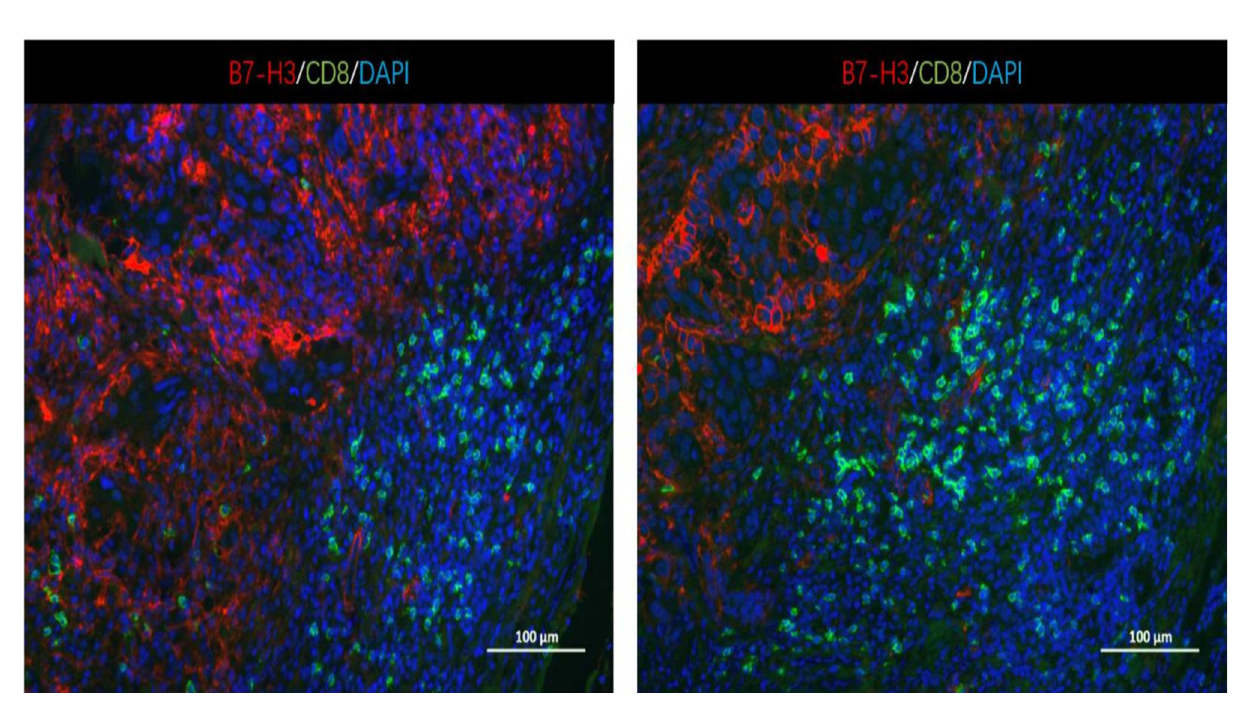
FIGURE 7 | Representative immuno fl uorescence images of B7-H3 and tumor-in fi ltrating CD8 + T cells in LSCC tissues. Original magni fi cation ×100; scale bar, 100 m m. No apparent colocalization of the B7-H3 (red) and CD8 (green) signal was